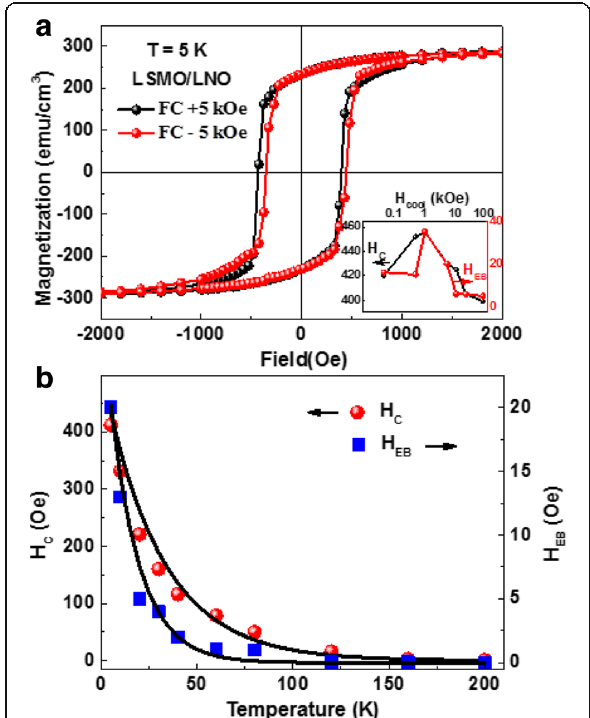
Fig. 4 a M – H loops measured on the LSMO/LNO bilayer at 5 K after an in-plain field-cooling (±5 kOe). The H C and H EB dependence on the cooling field is shown in the inset. b Temperature dependence of H EB and H C for the LSMO/LNO bilayer. The solid lines are the fit- tings to Eq.